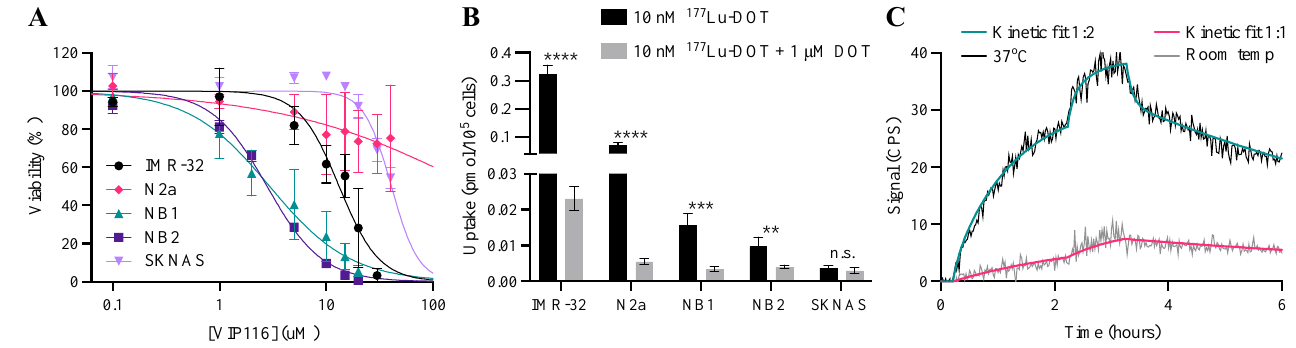
Figure 1. Characterization of neuroblastoma cell lines. ( A ) XTT viability assay after 72 h incubation with 0.1 –40 μM VIP116. IC 50 values are listed in Table 1. Pooled data from four independent experiments (mean ± SD). ( B ) Cellular specificity of 177 Lu-DOTATATE. Uptake of 177 Lu-DOTATATE without (black bars) or with (grey bars) blocking. Data from one representative experiment (mean ± SD, n = 4). n.s. = not significant, ** = p < 0.01, *** = p < 0.001 and **** = p < 0.0001. ( C ) Real-time uptake of 177 Lu-DOTATATE in IMR-32 cells in room temperature (grey) or at 37 ◦ C (black) with 1:1 (red) or 1:2 (green) kinetic models. Data from one representative experiment. Table 1. p53 status, MYCN status and IC 50 values from XTT and spheroid monotherapy assays. IC 50 data is presented as mean value (95% CI). wt = wildtype, mut = mutated, n.e. = not established, del = deletion, amp = amplified, n.amp = not amplified, Sph = spheroid assay, Ref = additional references for p53 and MYCN status.